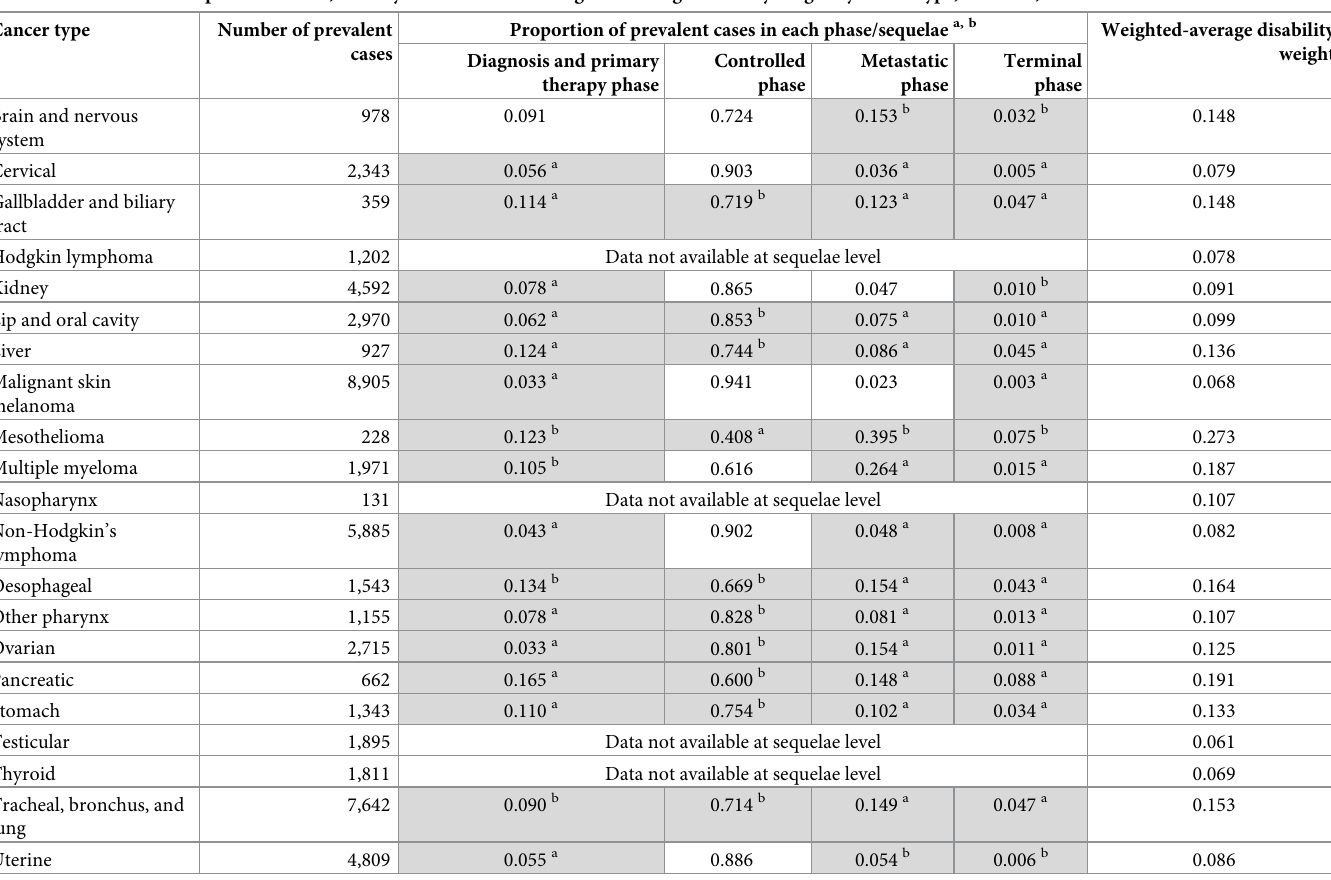
Table 1. Total number of prevalent cases, severity distribution and weighted-average disability weight by cancer type, Scotland,